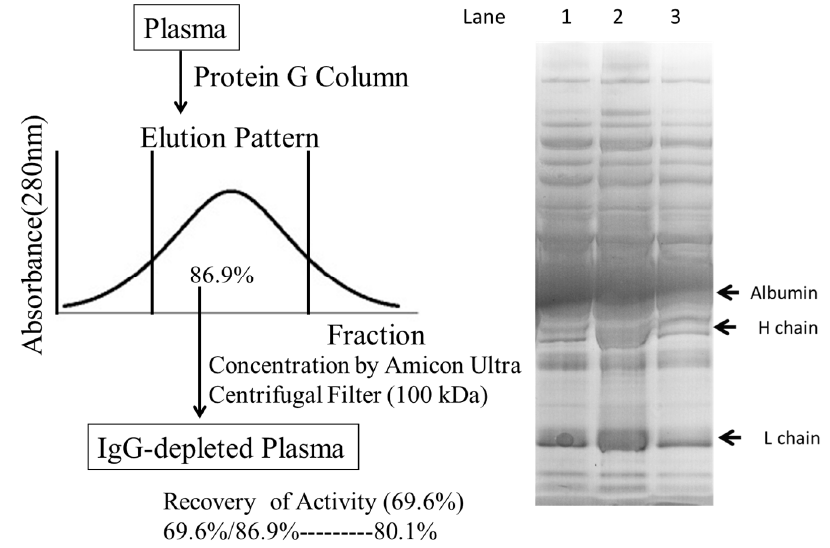
Figure 6. The preparation of IgG-depleted plasma and its Fe-ROMs value. Left panel: Plasma from a healthy subject was loaded onto a Protein G Sepharose 4 Fast Flow column, as described in the Section 4. The eluate was assayed for the determination of absorbance at 280 nm, and 86.9% of it was concentrated to obtain IgG-depleted plasma. Recovery of the Fe-ROMs value in IgG-depleted plasma was 69.6% as compared with the value for plasma; Right panel: Plasma and IgG-depleted plasma were analyzed on the 4%–12% SDS/PAGE as described in Figure 5. Lane 1: IgG-depleted plasma (44 µg protein), Lane 2: Plasma (43 µg protein), and Lane 3: IgG-depleted plasma (22 µg protein).